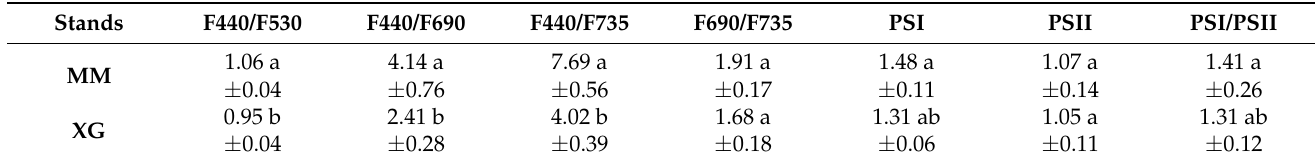
Table 2. Fluorescence emission coefficients of Filipendula vulgaris Moench leaves collected from the areas of Molinia meadows (MM) and xerothermic grasslands (XG); mean values (n = 5, ± SD) marked with different letters a, b differ significantly according to Tukey’s test (for different N) at p ≤ 0.05.